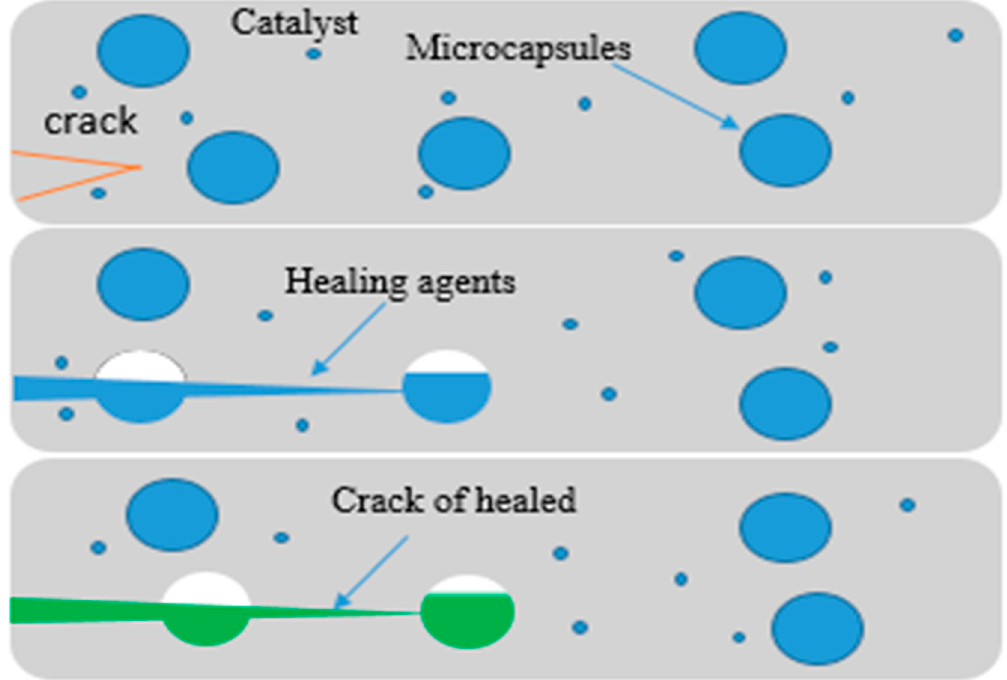
Figure 5. Autonomic self-healing: a micro-encapsulated healing agent is embedded with a catalyst (Grubb’s) in a structural epoxy matrix capable of polymerizing the healing fluid. (Adapted from [29]).